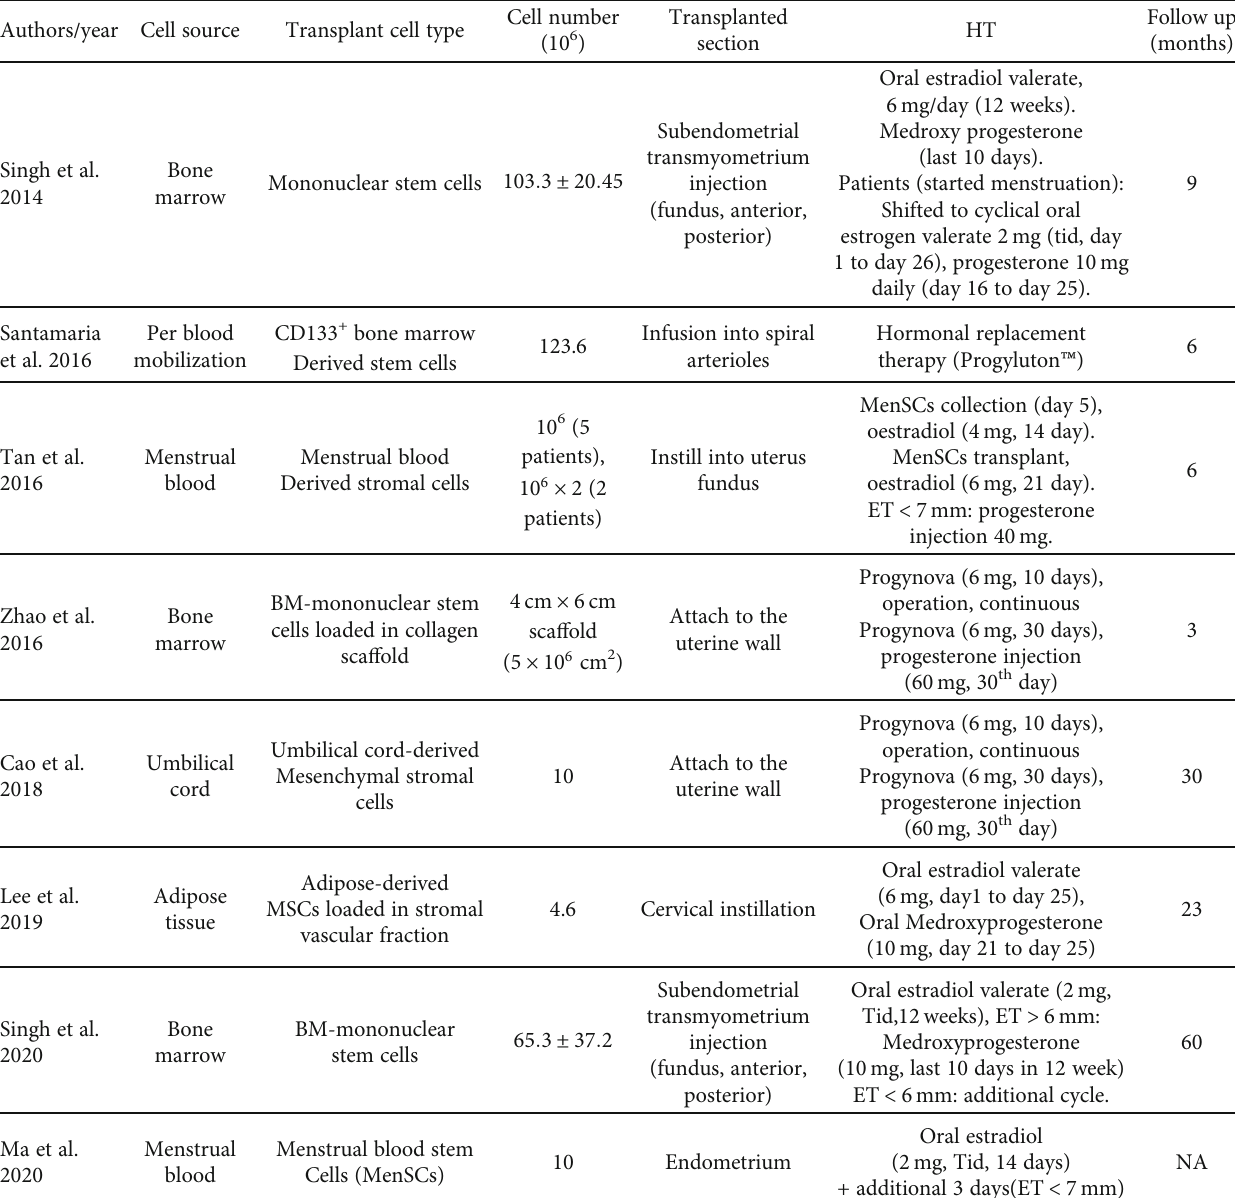
Table 2: Characters of stem cell-based therapy in treating AS